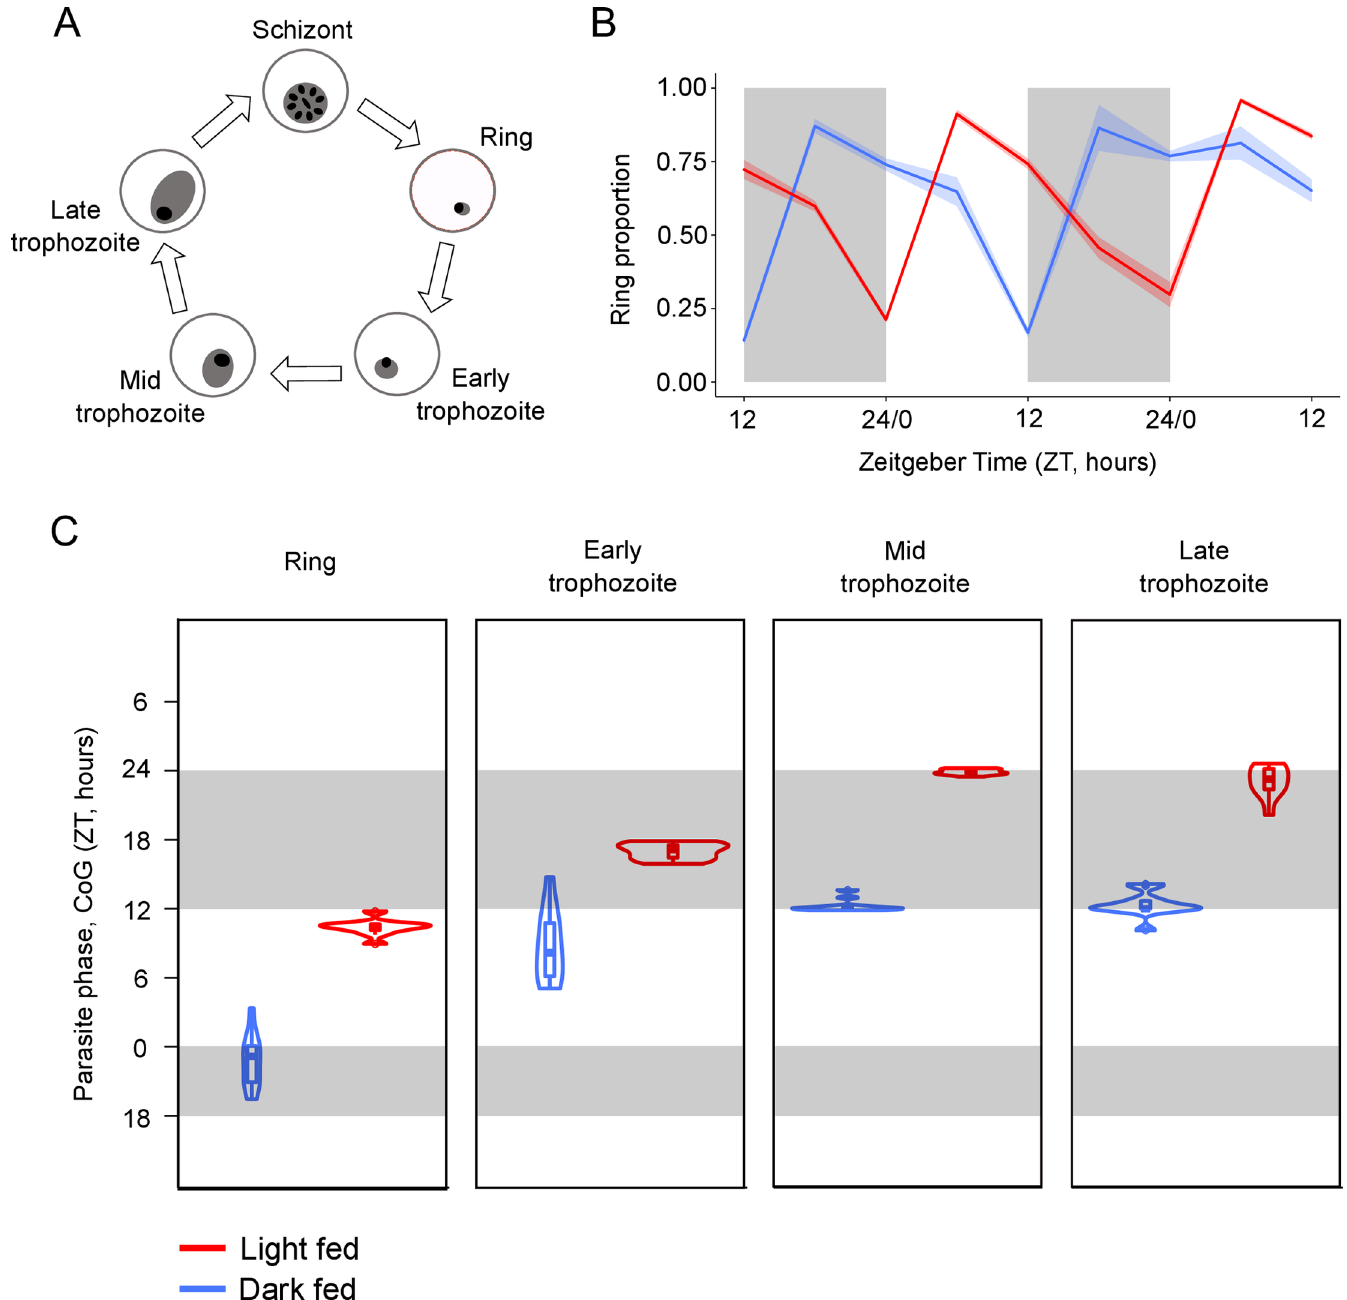
Fig 3. Parasite rhythms are inverted in hosts fed during the day compared to the night. (A) The asexual cycle of malaria parasites is characterised by five morphologically distinct developmental stages (ring, early trophozoite, mid trophozoite, late trophozoite) differentiated by parasite size within the red blood cell, the size and number of nuclei, and the appearance of haemozoin [31]. (B) Mean ± SEM (N = 10 per group) proportion of observed parasites in the blood at ring stage in light fed mice (red; allowed access to food during the day, between ZT 0 and ZT 12) and dark fed mice (blue; allowed access to food during the night, between ZT 12 and ZT 24). The proportion of parasites at ring stage in the peripheral blood is highest at night (ZT 22) in dark fed mice but in the day (ZT 10) for light fed mice, illustrating the patterns observed for all other (rhythmic) stages (see S2 Fig). (C) CoG (estimate of phase) in ZT (h) for each rhythmic parasite stage in the blood. Each violin illustrates the median ± IQR overlaid with probability density (N = 10 per group). The height of the violin illustrates the variation in the timing of the CoG between mice and the width illustrates the frequency of the CoGs at particular times within the distribution. Sampling occurred every 6 hours days 6–8 post infection. Light and dark bars indicate lights on and lights off (lights on: ZT 0, lights off: ZT 12).